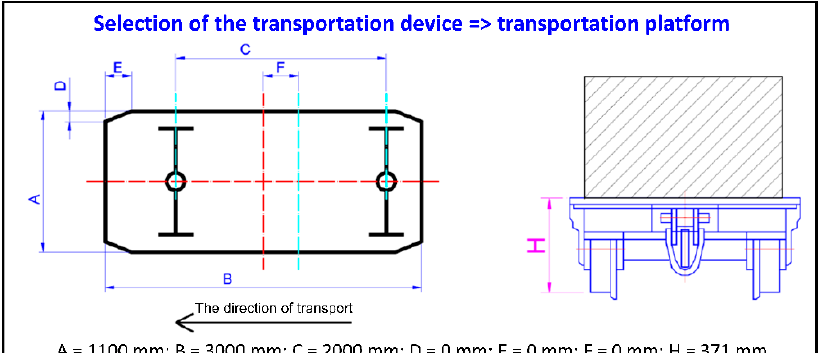
Figure 12. Input data for development of the simulation model in AutoCAD environment—transportation device.